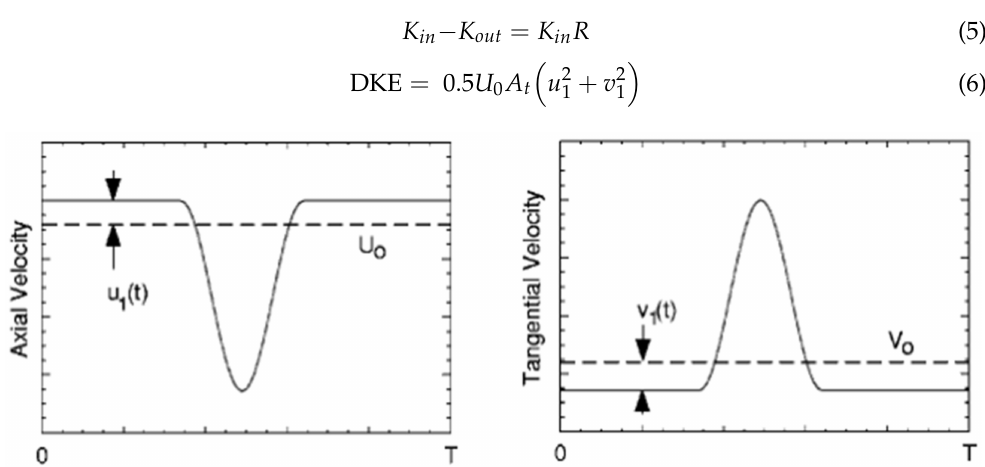
Figure 17. Velocity components of disturbance kinetic energy.